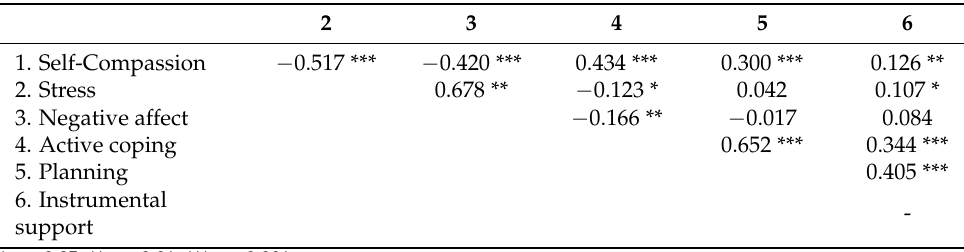
Table 2. Correlations of the variables of interest for Model